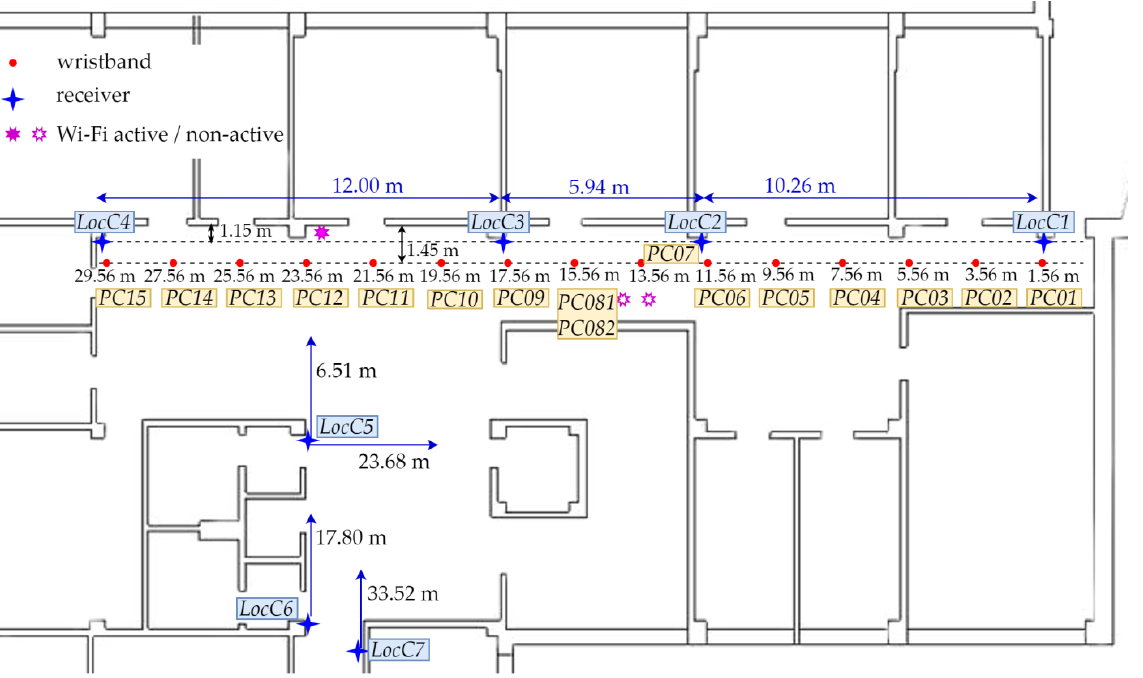
Figure 4. Location of the wristband ( PC01 , . . . , PC15 ) and its position relative to the locator nodes ( LocC1 , . . . , LocC7 ) during a series of measurements in Stage C.